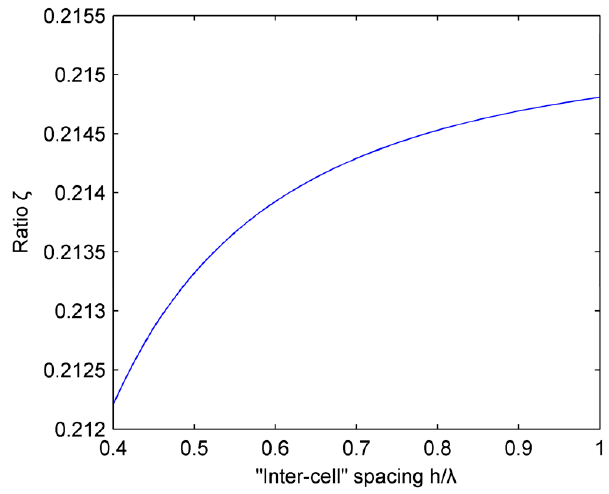
Figure 11. Influence of “inter-cell” spacing on the ratio ξ .